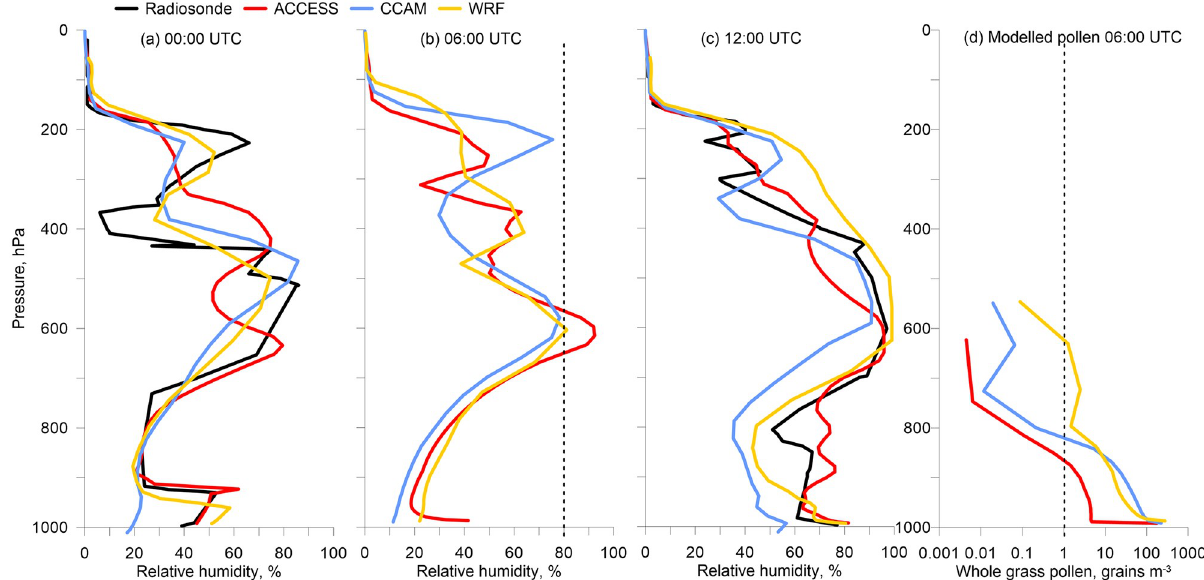
Fig 4. (a-c) radiosonde observations at Melbourne Airport compared to model predictions for the 21 November 2016 of relative humidity from the surface to 0 hPa in each meteorological model. (d) pollen concentrations in VGPEM1.0 driven by each meteorological model. Dashed lines in (b) and (d) represent the thresholds for rupturing at 80% RH and 1 grain m -3 , respectively. The maximum height of modelled pollen differs because CCAM and WRF are output on pressure levels, whilst the ACCESS height is converted to hPa from the 5 km model